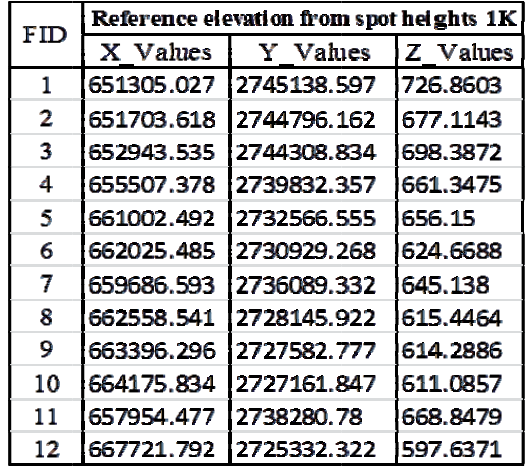
The results obt stream